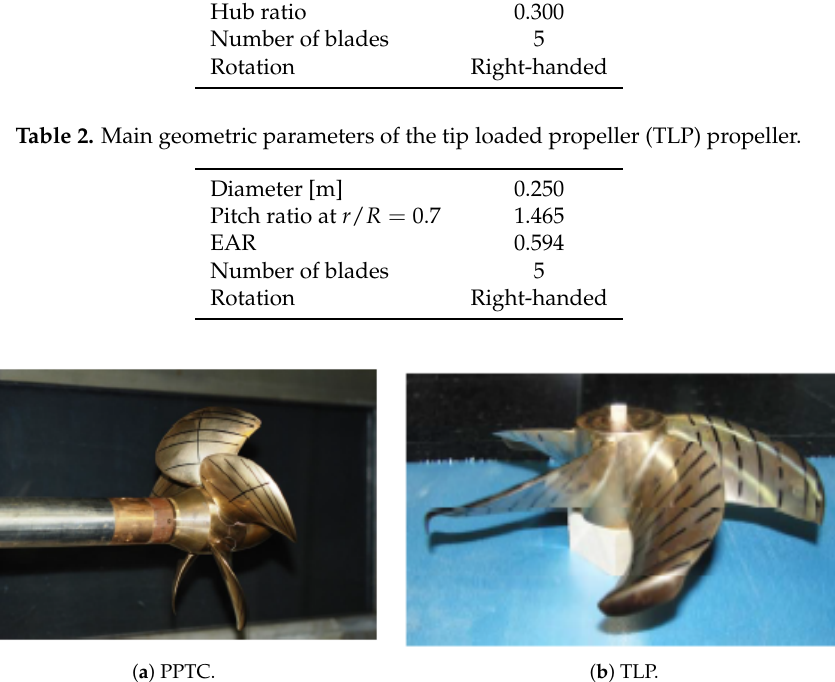
Figure 2. Photographs of the investigated propellers. The black circles on the blades show the reference radii. Photograph of PPTC taken from Ref. [26] and reproduced with permission from Lars Lübke (SVA). Photograph of TLP reproduced with permission from Michael Brown